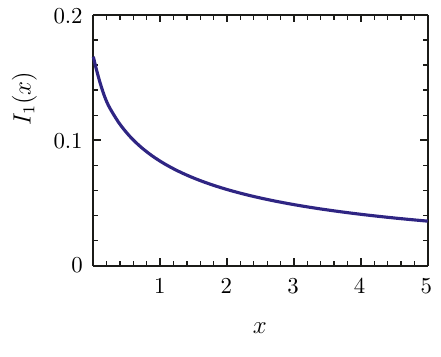
Figure 3 . The loop function I 1 ( x